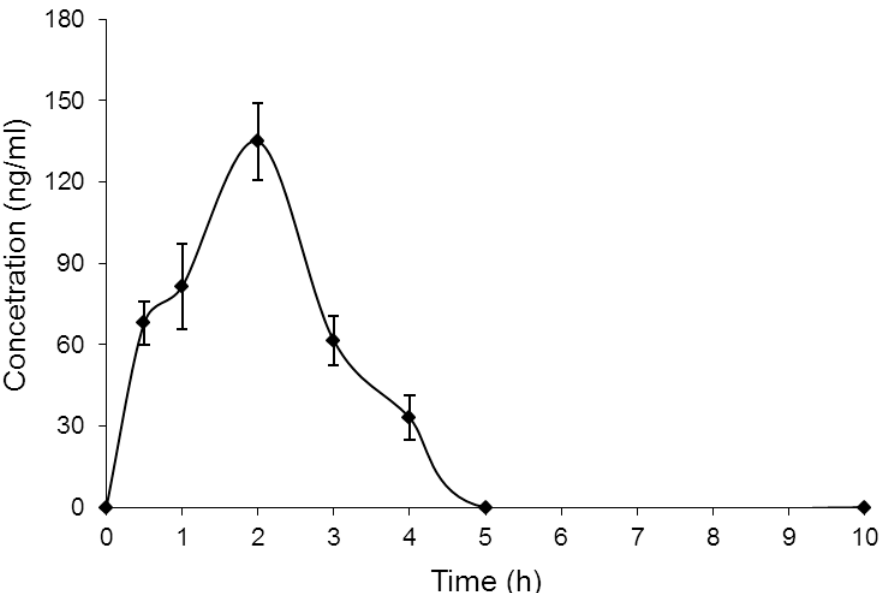
Figure 3. The concentration–time curve of clonidine in mice plasma after administration with 2 mg / kg of clonidine (each point equal mean ± SD).